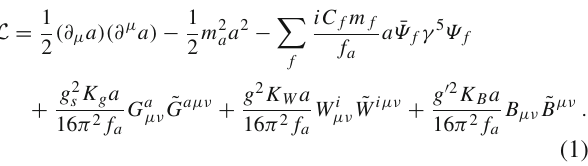
tops, and κ V , t are the corrections from compositeness to